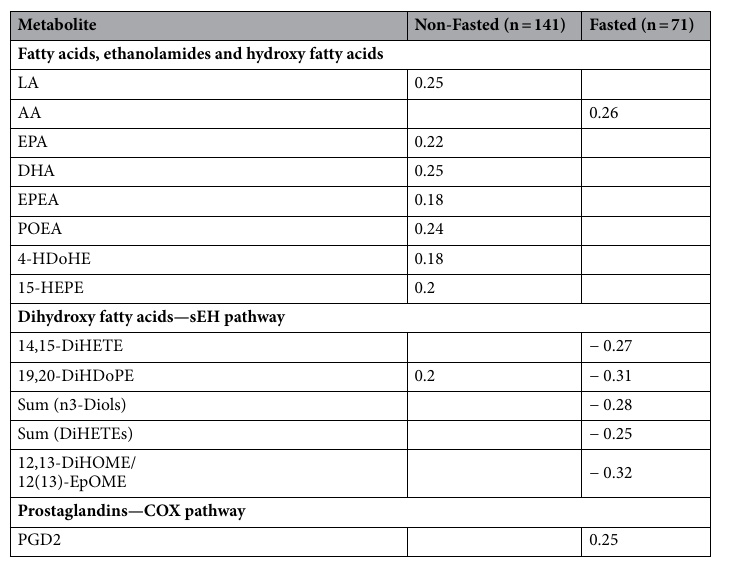
Table 1. Spearman’s rank order correlations between serum oxylipins and endocannabinoids and perceptual speed. The numbers represent Spearman’s ρ with the p value < 0.05 and FDR corrected with the q = 0.2. Full names of all identified compounds are presented in the Supplemental Table S2 and correlation for all cognitive domains are presented in the Supplemental Table S3.